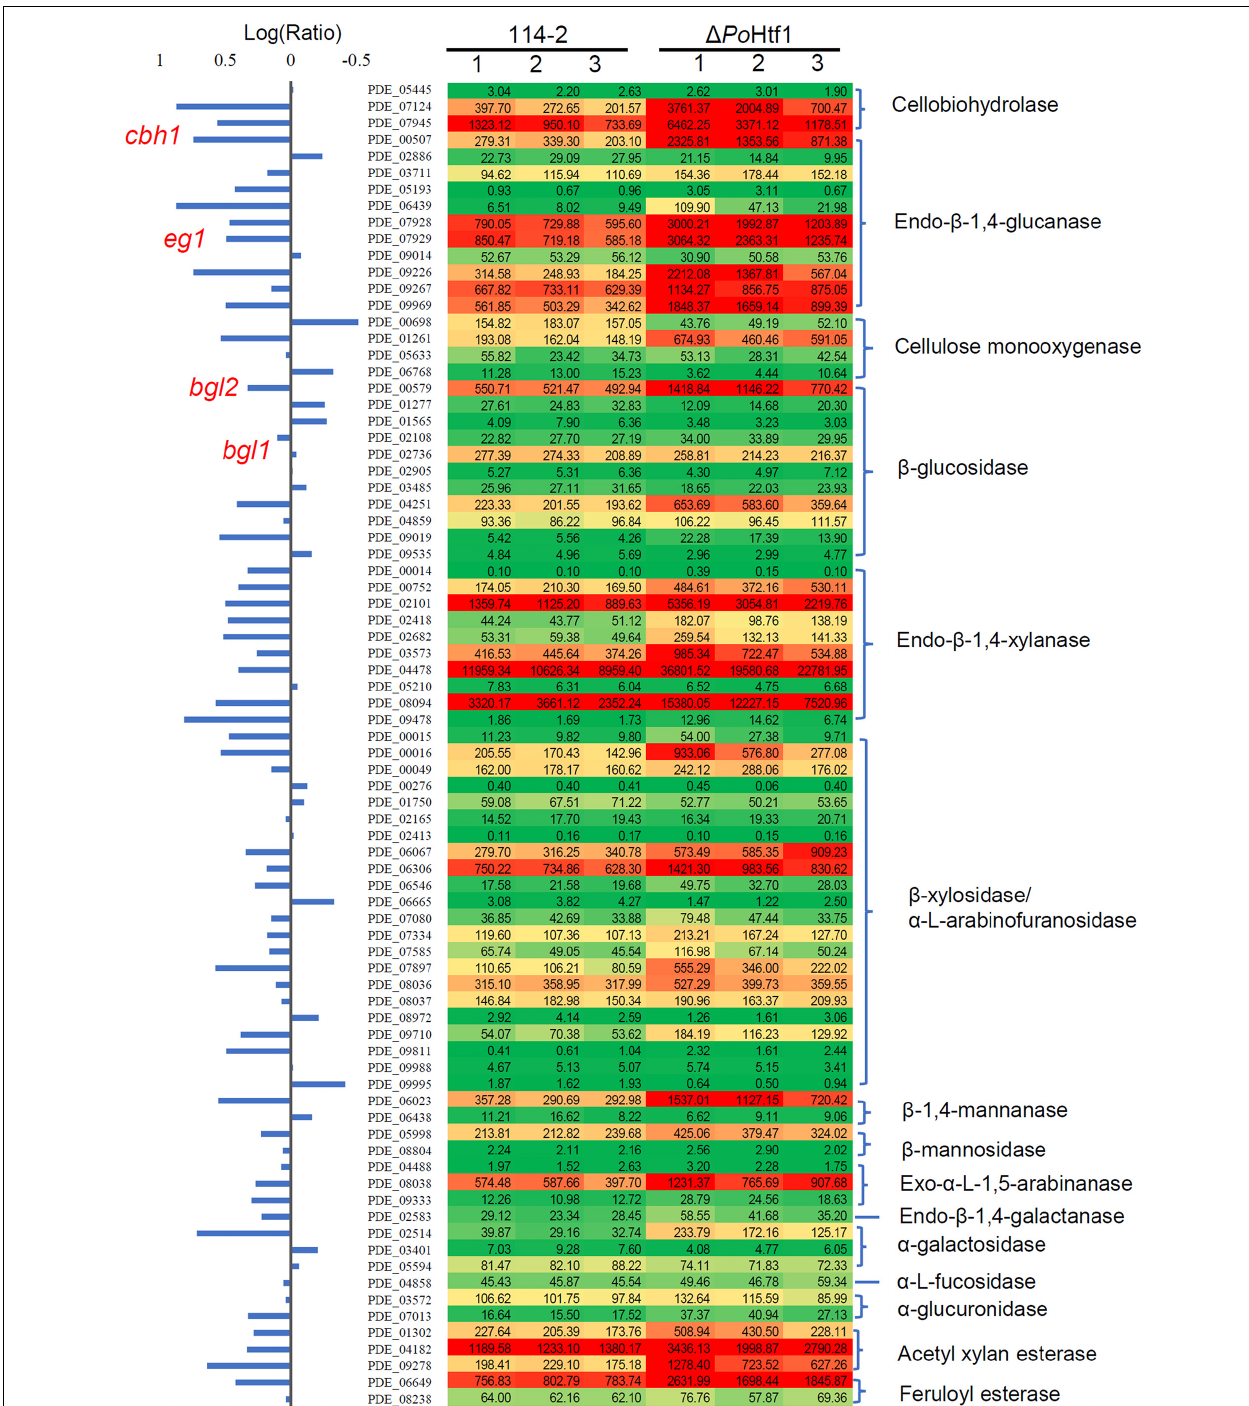
FIGURE 3 | Expression profile of 80 annotated cellulose hydrolyase genes in P. oxalicum 114-2 and (cid:49) Pohtf1 . The expression levels (RPKM) of the 80 genes are labeled by green-yellow-red color scales in excel. The minimum value is 0, the median is 100, and the maximum value is 36,801.